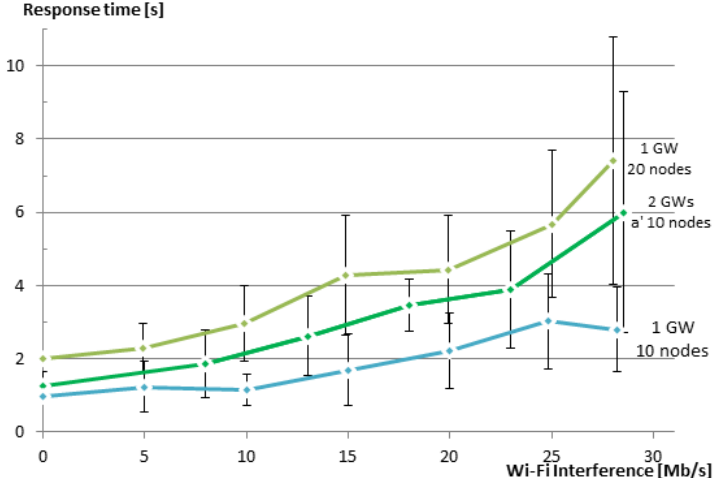
Figure 13. Entity response time in the presence of Wi-Fi interference for an entity of 20 members versus a nested entity consisting of two smaller entities having each 10